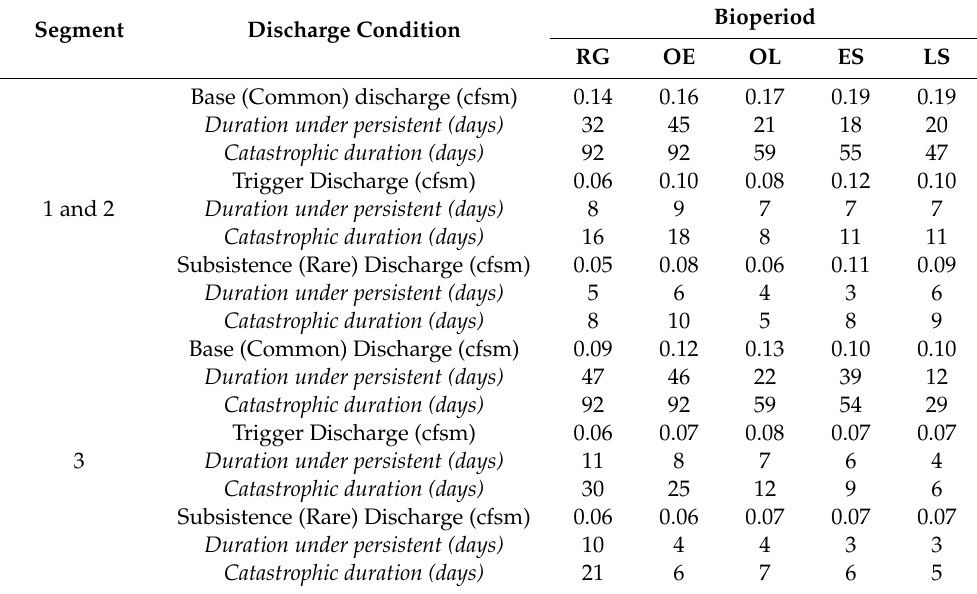
Table 4. Discharge levels (cfsm) recommended for each bioperiod in all three river segments of the Niobrara River, NE. Bioperiods are based on seasonal changes in precipitation and temperature as well as on life-history stages of fishes and include: Rearing and growth (RG; 1 July to 30 September), overwinter early (OE; 1 October to 31 December), overwinter late (OL; 1 January to 28 February), early spring (ES; 1 March to 14 May), and late spring (LS; 15 May to 30 June). Recommended discharges based on a time series of long-term hydrologic data from the Niobrara River and continuous under threshold (UCUT) analysis [26]. A persistent event is likely to occur every few years, but at the intra-annual scale, these long events are unusual (i.e., do not happen more than twice in a year). Catastrophic events